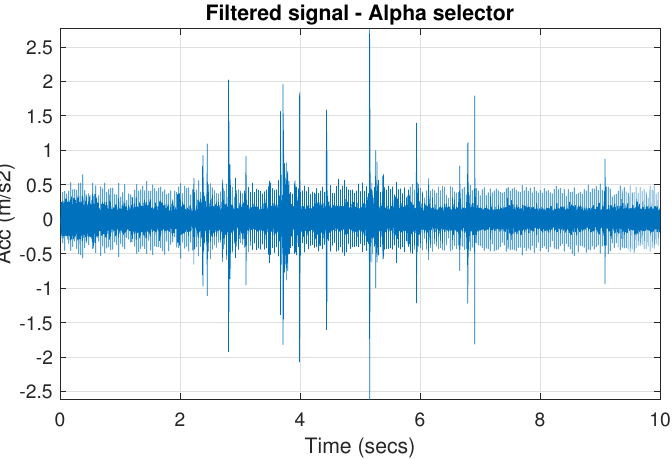
Figure 42. Filtered signal r by Alpha selector.